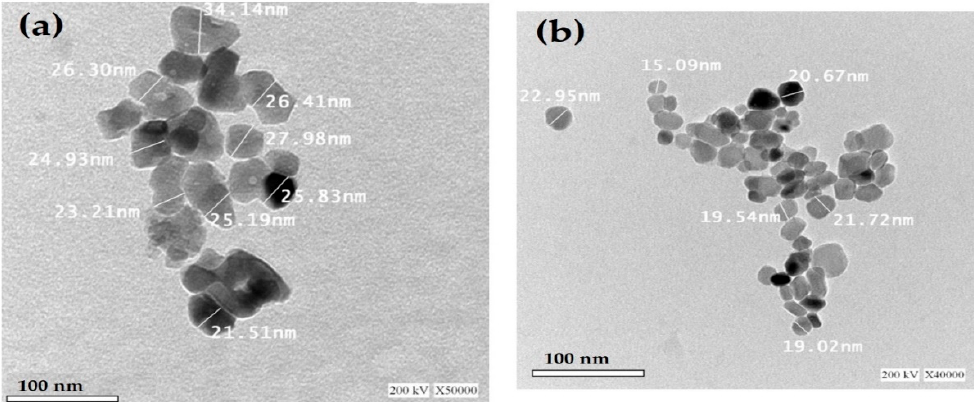
Figure 2. TEM for ( a ) ZrO 2 NP and ( b ) Cr 2 O 3 nanoparticles (NPs) structure.